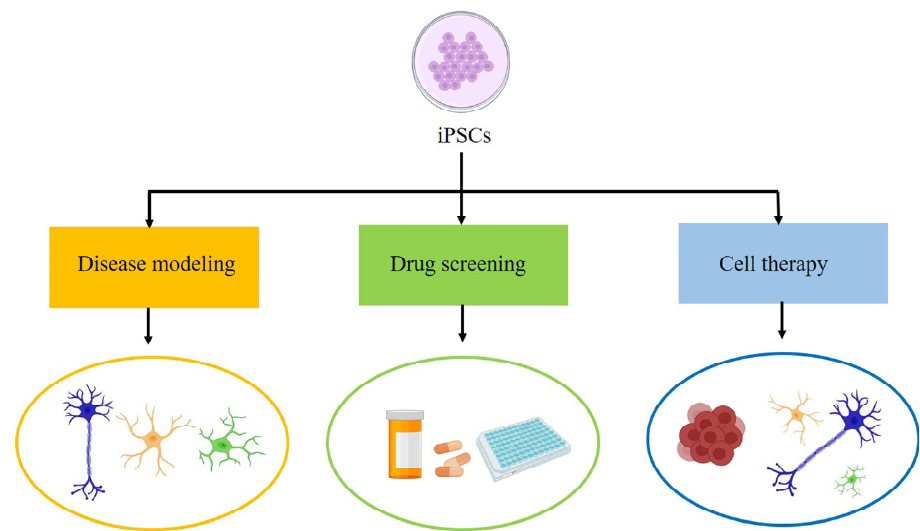
Figure 1. Applications of iPSCs (in the case of ALS). Disease modeling: neurons and glial cells; Drug screening: high-throughput screening; Cell therapy: neural stem cells, neural progenitor cells, neurons and glial cells.